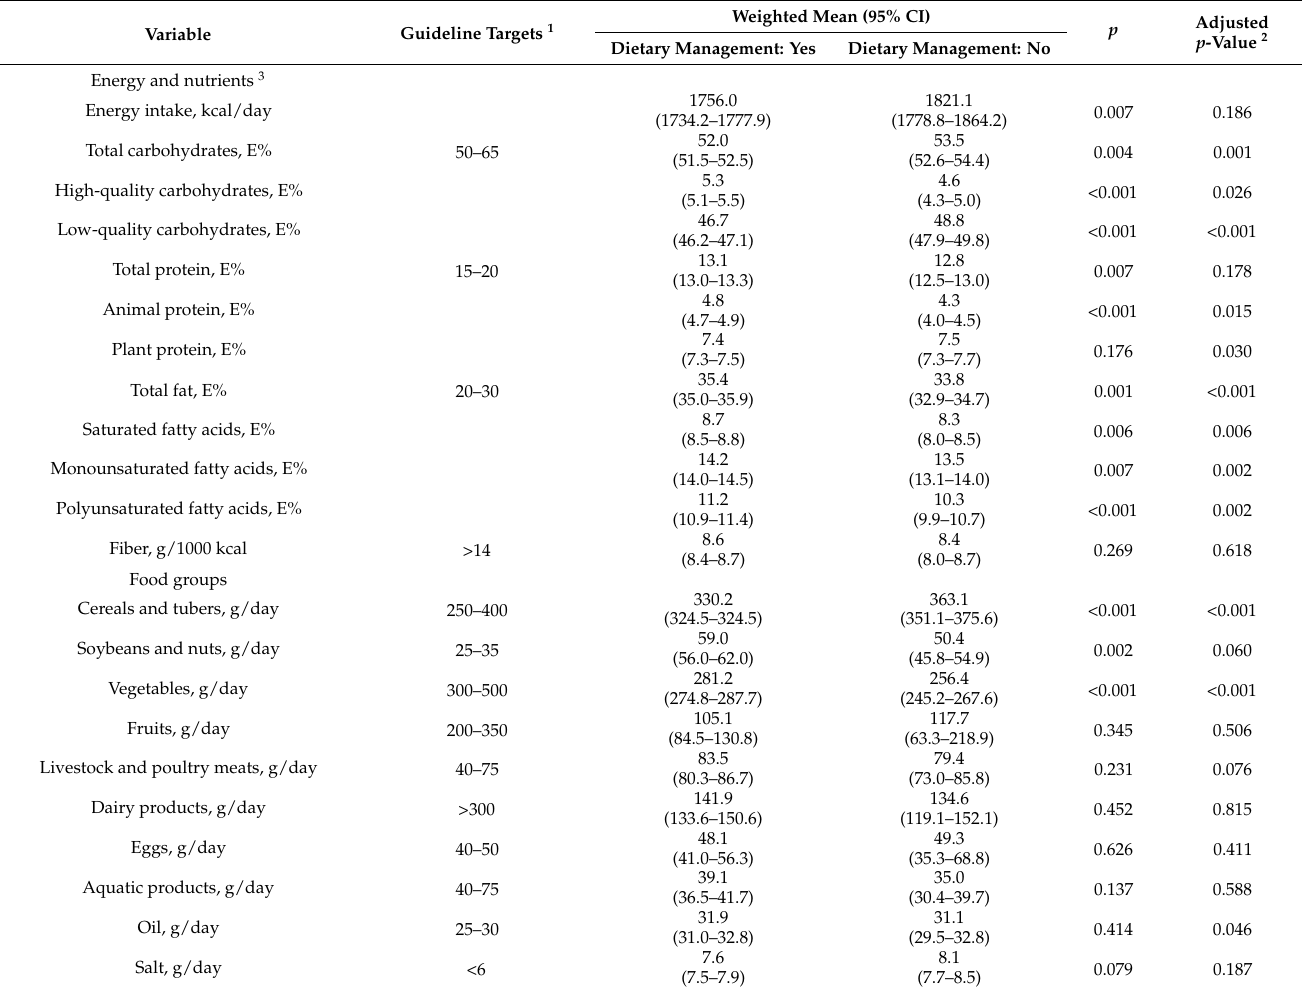
Table 2. Mean intake of dietary-related items among Chinese adults with diabetes in the three rounds of China National Nutrition